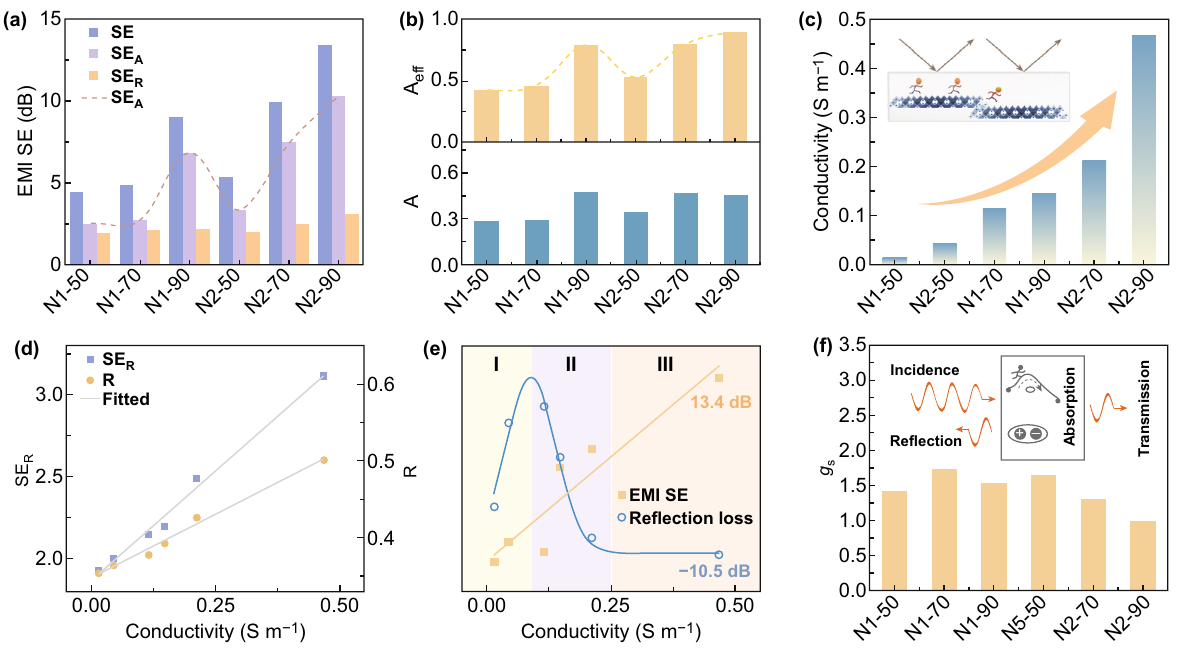
Fig. 5 a Average EMI SE, SE A , and SE R of different NiCo 2 O 4 composites. b Average effective absorption and absorption coefficient of different composites. c σ of the NiCo 2 O 4 composites. Sort in ascending order. Inset: schematic of the effect of σ on material properties. d SE R and reflec‑ tion coefficient versus σ . e Tendency of EM absorbing and shielding caused by charge transport. f g s of each sample. Inset, schematic of EM wave incidence, reflection, transmission, and